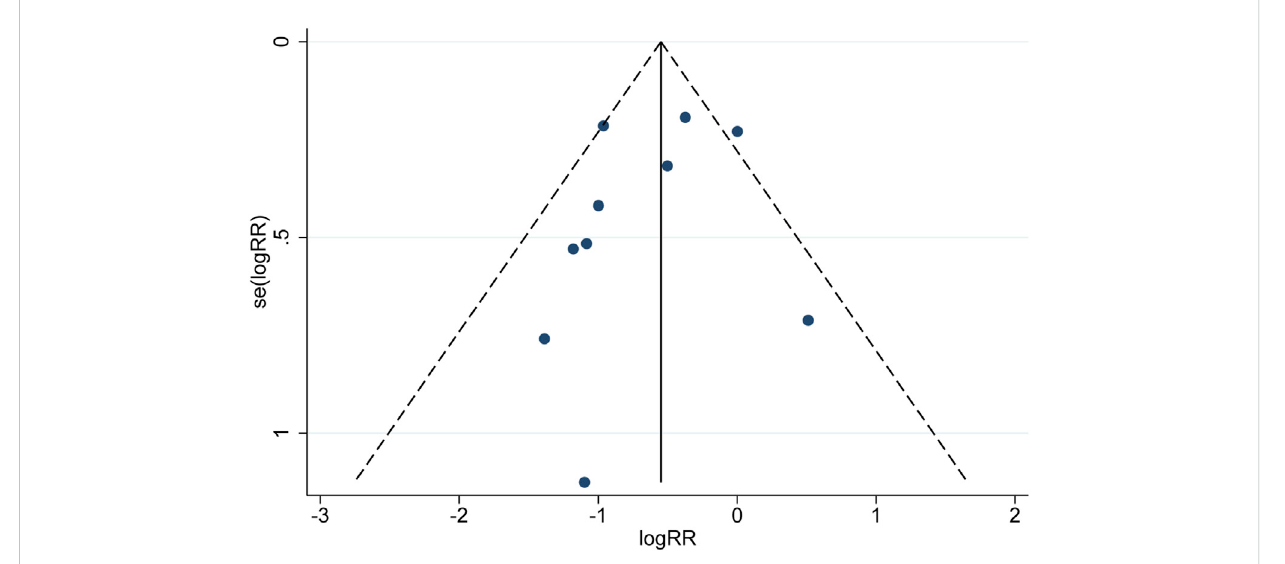
FIGURE 9 Funnel plot of incidence of major adverse cardiovascular events